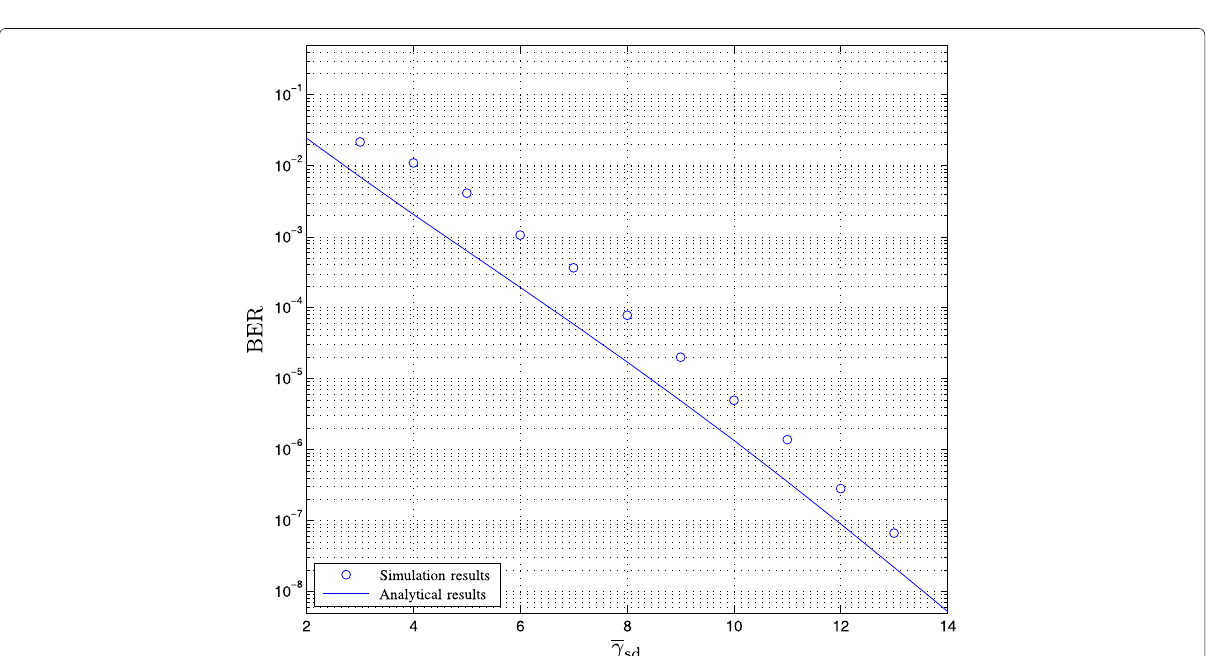
Fig. 6 BER of a two-hop cognitive relay channel as a function of γ sd using a CCSDS turbo-coding scheme. With interleaver size N = 16, and for = d / d = 1 and I / P = 0 dB, lines correspond to the analytical results, and hollow markers correspond to simulation δ p rp rd